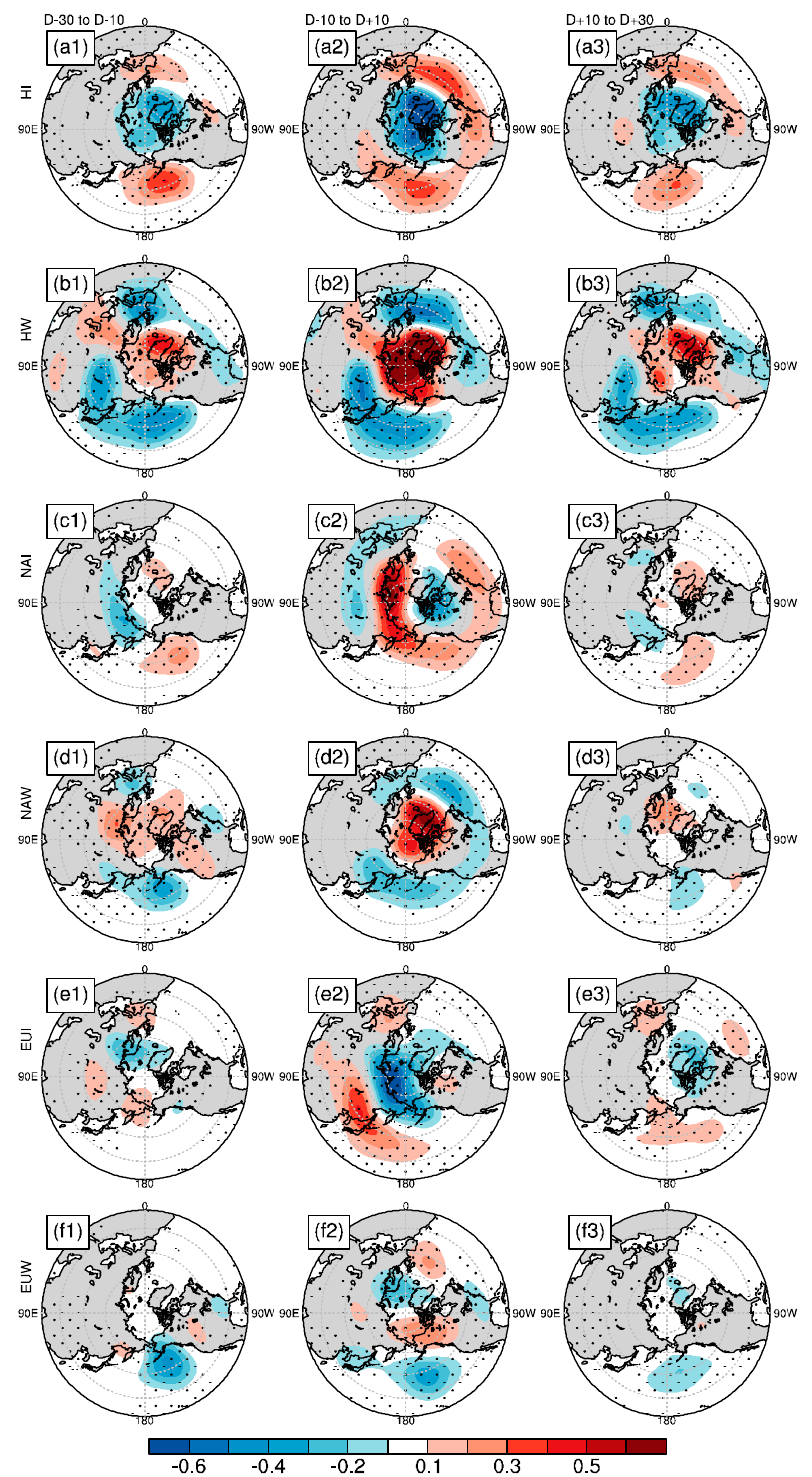
Figure 5. Composited leading/lagging evolutions of standardized 500 hPa geopotential height anomalies (shading) during three stages from 20 to 90°N for six stratospheric Arctic vortex weather regimes. ( a1 – f3 ) The clusters 1-6 are printed as HI, HW, NAI, NAW, EUI, and EUW regimes, respectively. The first column displays the average for days -30 to -10, the second column displays the average for days -10 to 10, and the third column displays the average for days 10 to 30. The dotted area indicates the composited anomalies significant at the 99% confidence level.